Question: Write the caption for this figure.
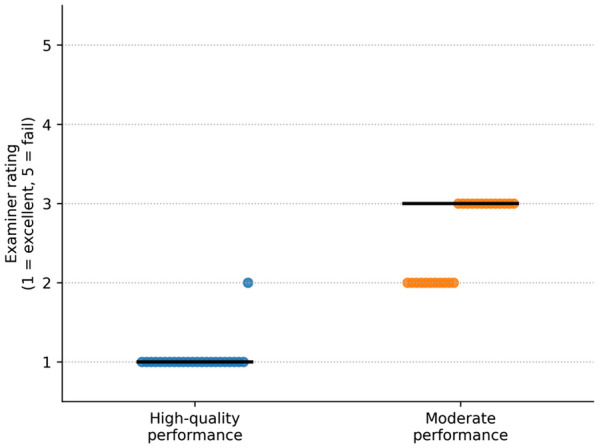
Answer: shows a scatter plot of examiner ratings for two standardized performances in a structured oral examination. Ratings were given on a five-point scale, with 1 indicating excellent performance and 5 indicating fail. The high-quality performance is clustered almost entirely at rating 1, with one rating at 2, whereas the moderate performance is clustered at ratings 2 and 3. Horizontal lines indicate the median ratings. The figure illustrates clear separation between the two predefined performance levels and limited variability within each rating group.